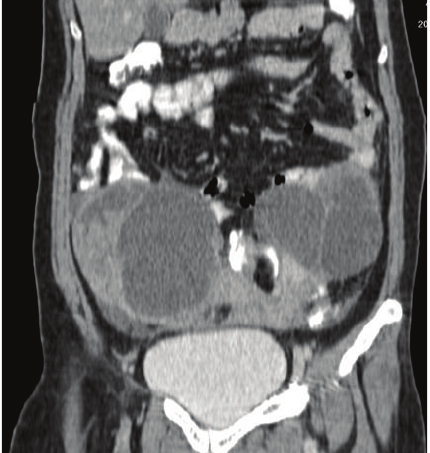
Figure 2: CT scan of the abdomen showing predominantly cys- tic lesions with internal septations and solid component which appeared after contrast enhancement in bilateral adnexal regions of size 98 × 88 × 107 mm on right side and 110 × 52 × 94 mm on left